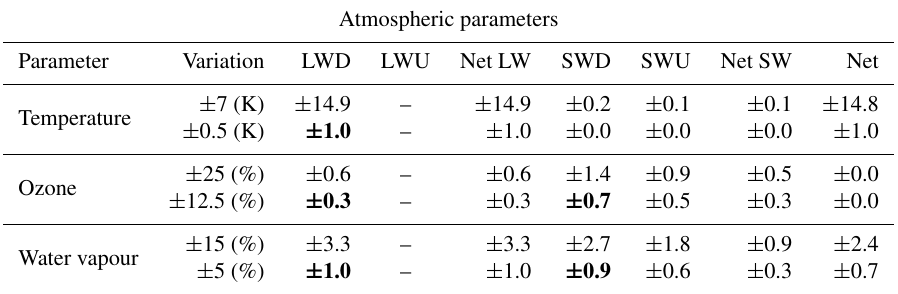
Table A1. Results of the sensitivity analysis, varying several atmospheric parameters. The table indicates the mean upward (U) and downward (D) SW and LW flux differences at the surface of clear-sky (CS) perturbed simulations minus idealized atmosphere simulation. Values in Wm − 2 . Values highlighted in bold are used as uncertainties.